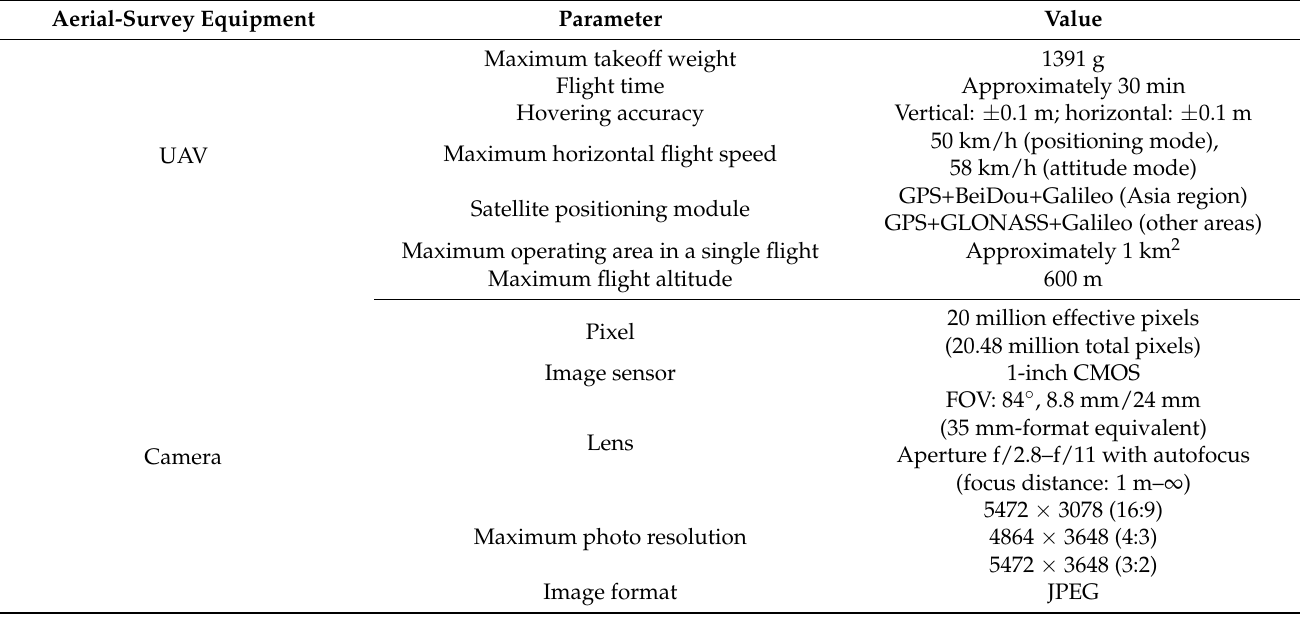
Figure 2. DJI Phantom 4 RTK UAV. Table 1. Technical parameters of UAV and optical sensors.